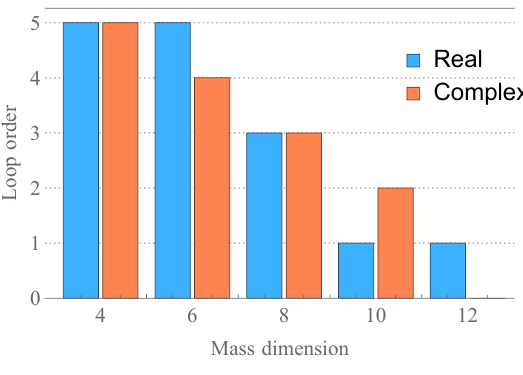
Figure 1 . Summary of the operator anomalous dimensions we obtain in the real and complex φ 4 effective theories in this